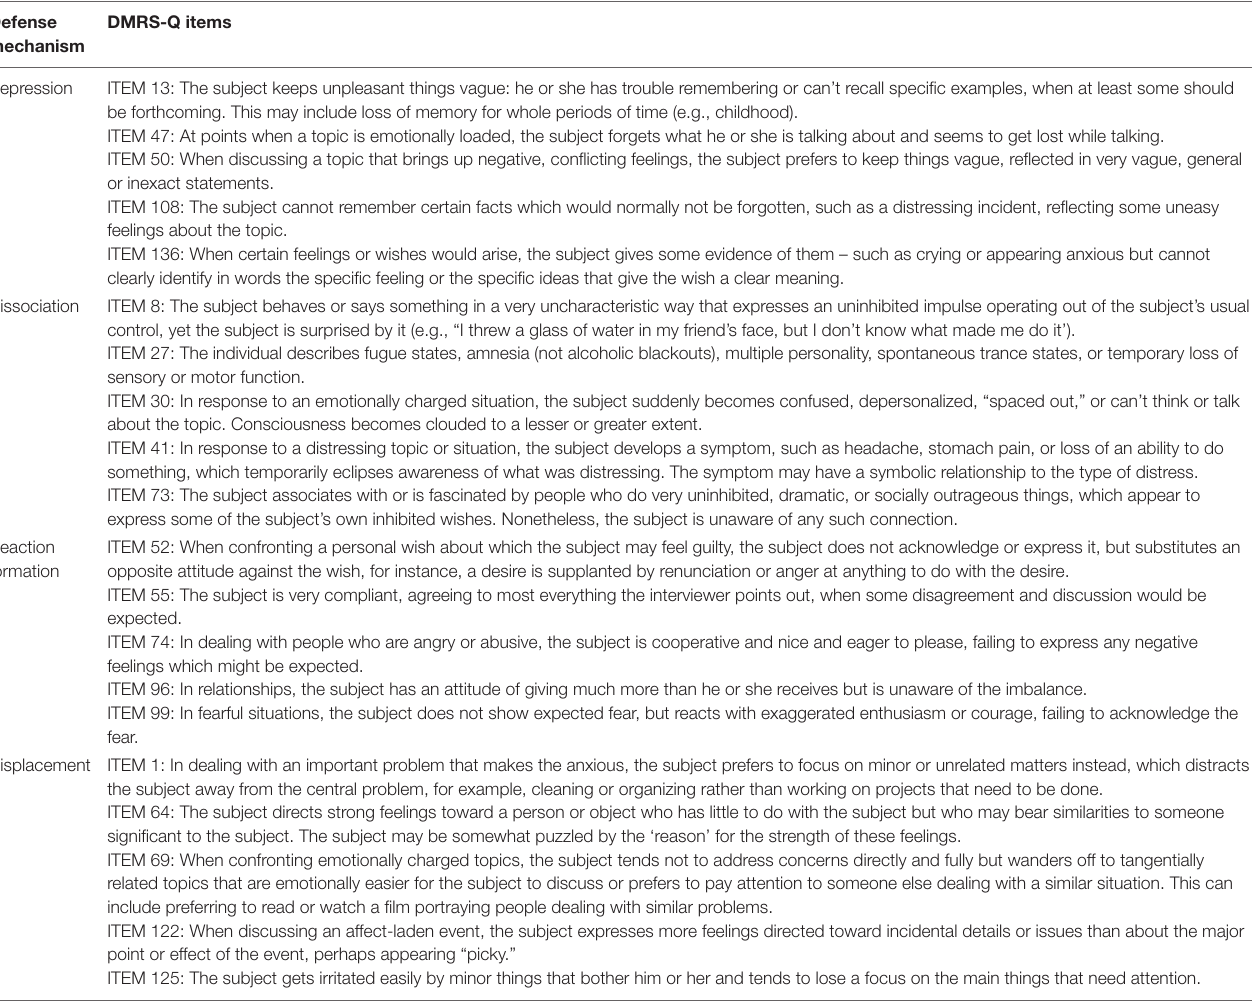
TABLE 4 | Neurotic defense level: Definition, function and DMRS-Q items of defenses repression, dissociation, reaction formation, and displacement. Defense DMRS-Q mechanism